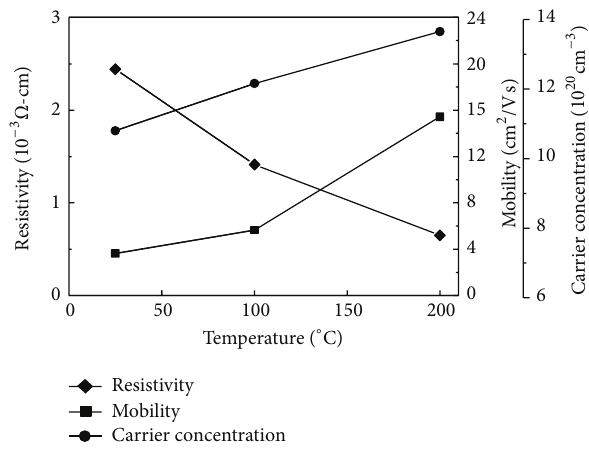
), short-circuit current oc